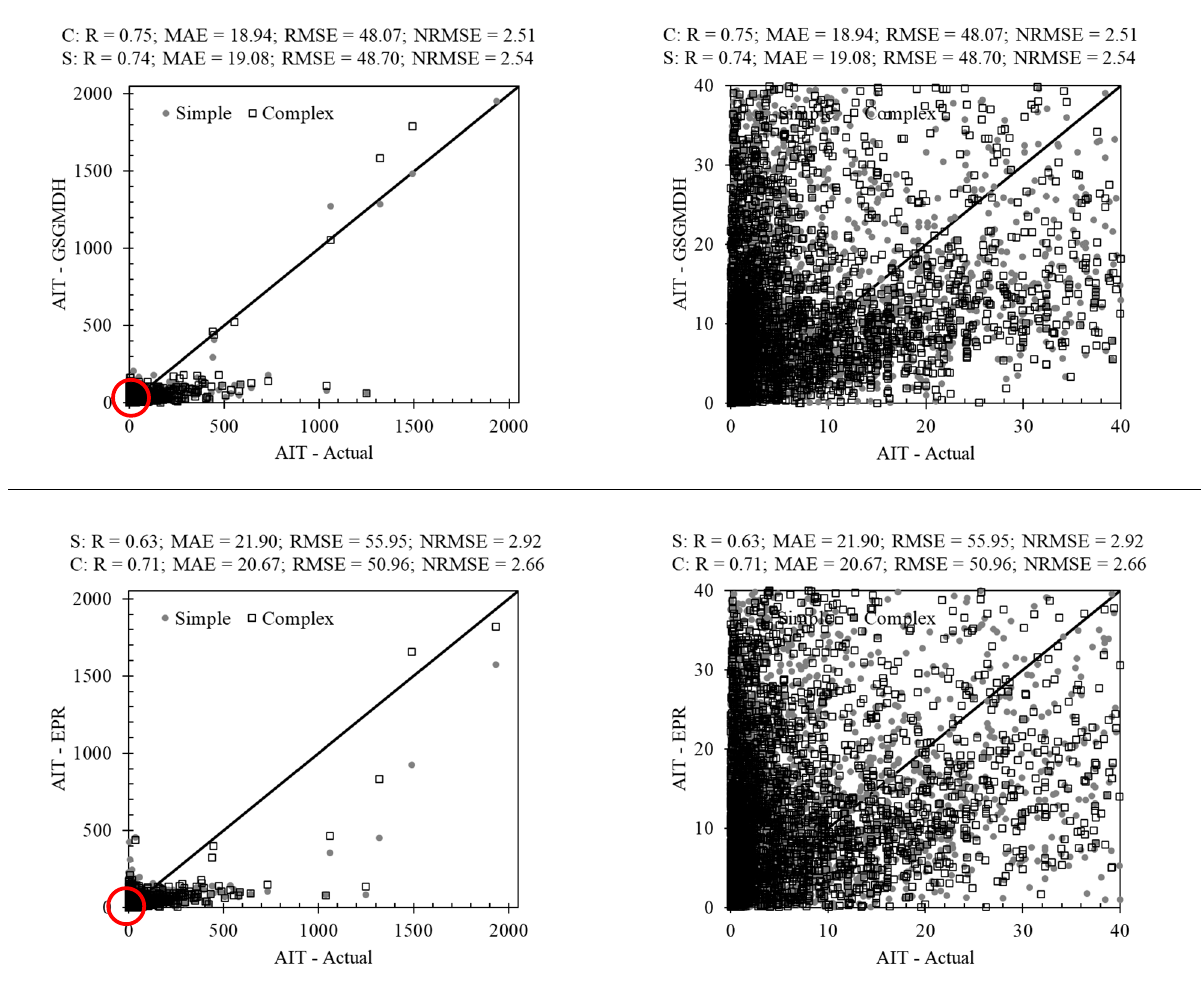
Figure 6. Scatter plot of the non-tree-based techniques in AIT forecasting. Plots on the right are a scaled-up view of the region circled in red in the left plot.